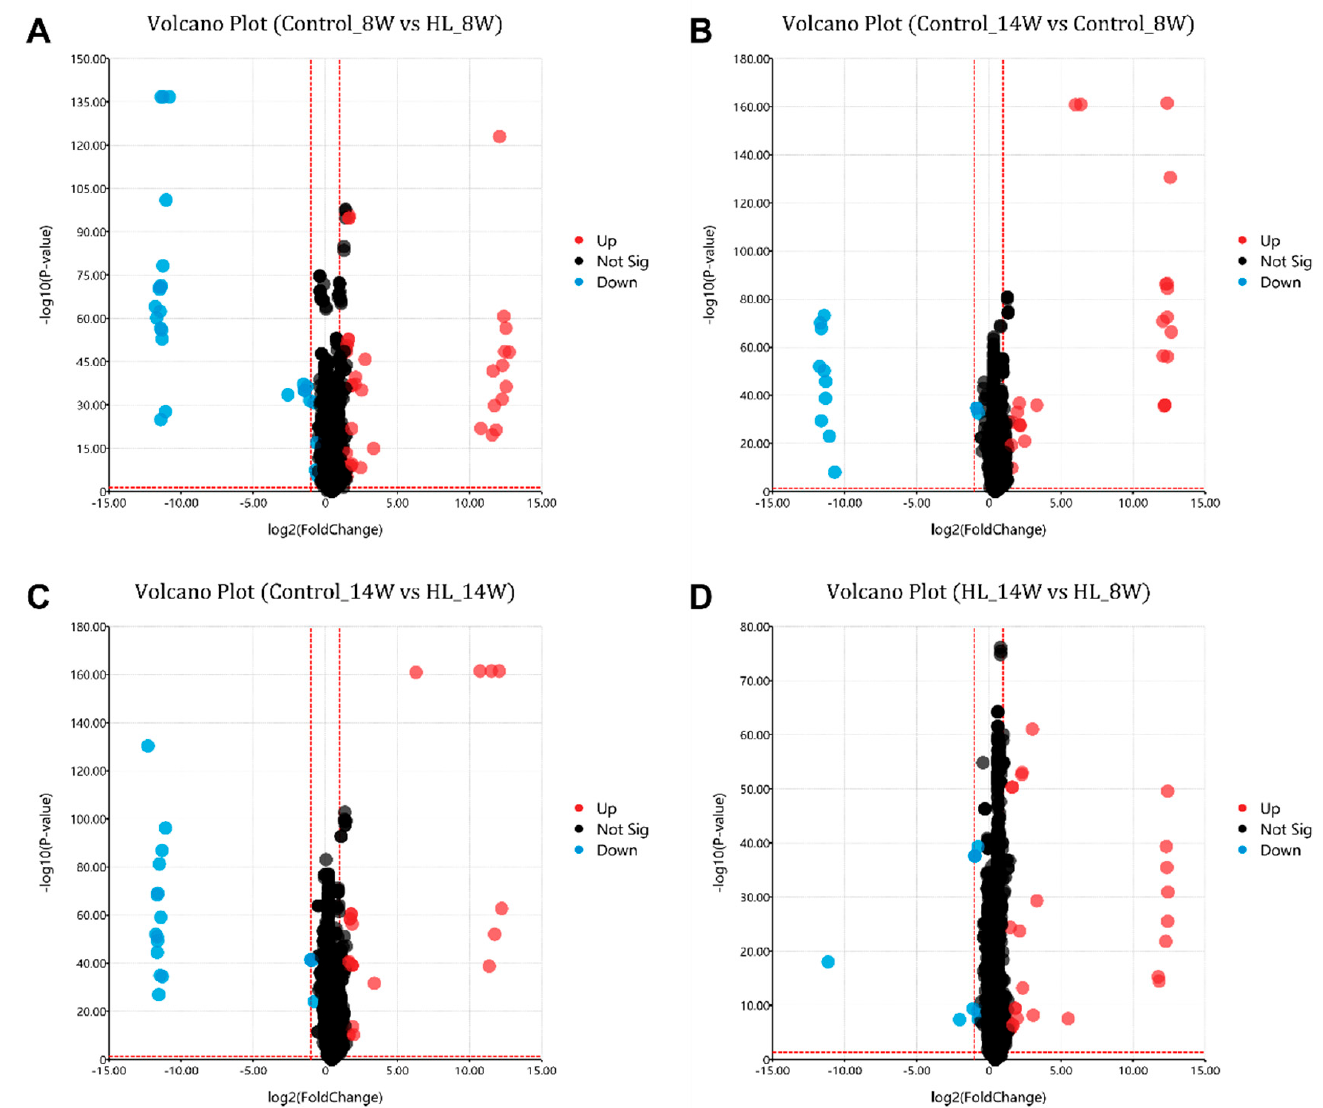
Figure 5. Volcanic diagram analysis of differential metabolites. ( A ) Volcanic diagram analysis of Control_8W vs. HL_8W. ( B ) Volcanic diagram analysis of Control_14W vs. Control_8W. ( C ) Volcanic diagram analysis of Control_14W vs. HL_14W. ( D ) Volcanic diagram analysis of HL_14W vs. HL_8W. Red, blue, and black points denote upregulated metabolites, downregulated metabolites, and nonsignificant metabolites, respectively. n = 4; the sample repeat for each group was four rats.